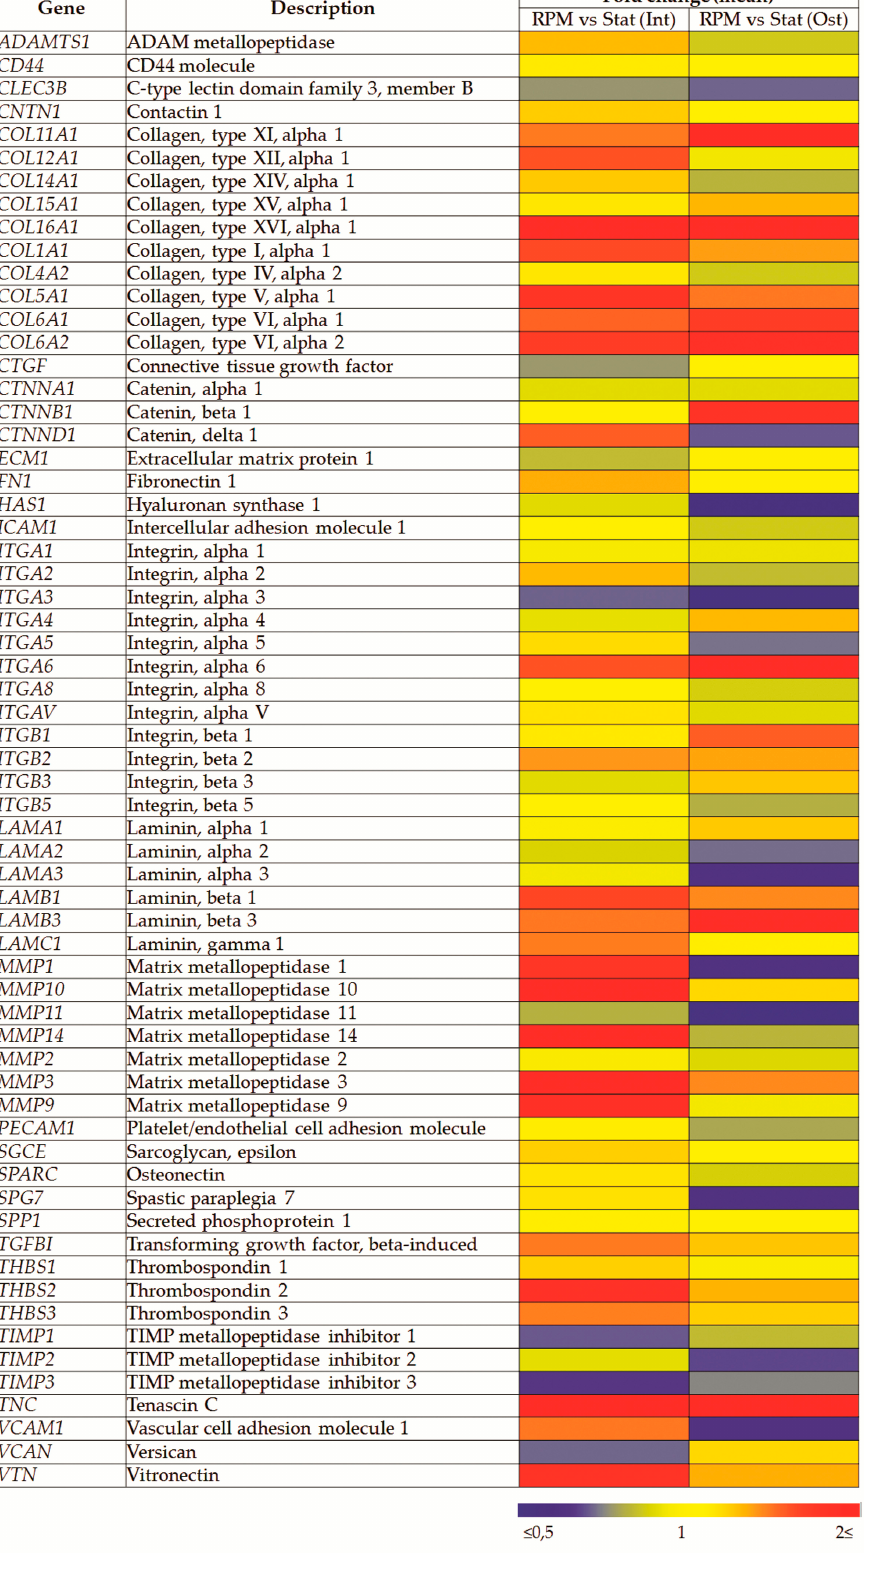
Figure 9. Relative expression of matrix/adhesion associated genes after 10 days of RPM exposure. Heatmap, n ≥ 3. Int—intact cells; Ost—osteocommitted cells; Stat—static control; RPM—random positioning